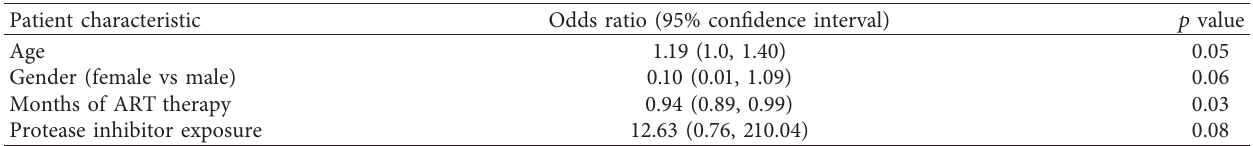
Table 3: Logistic regression analysis for predicting FFR in patients living with